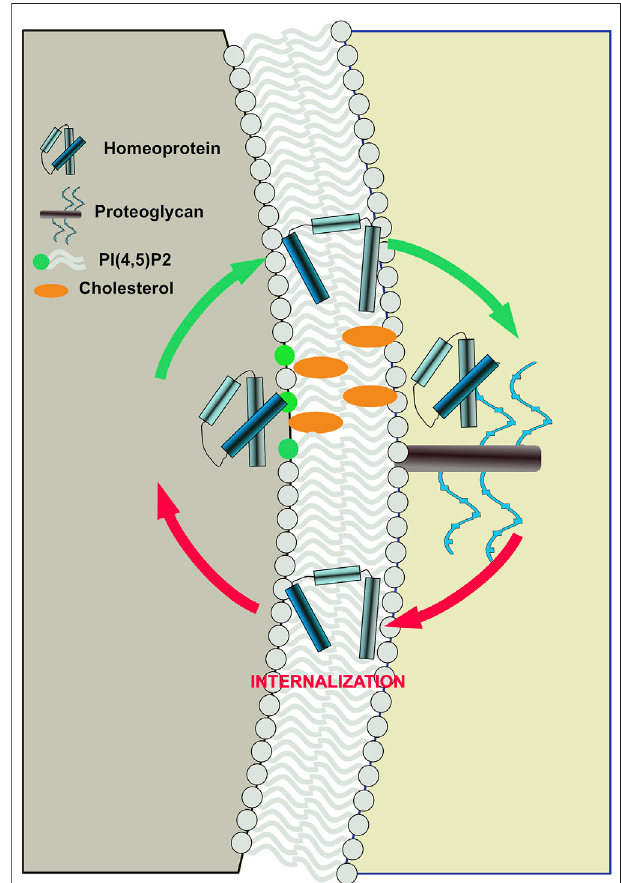
FIGURE 2 | Proposed model of bidirectional translocation of EN2 homeoprotein across the plasma membrane. Interaction with PI(4,5)P2 and cholesterol at the inner side and with glycosaminoglycan at the outer side, act asaconformationalswitches forEN2 allowing its exchange between the polar and apolar